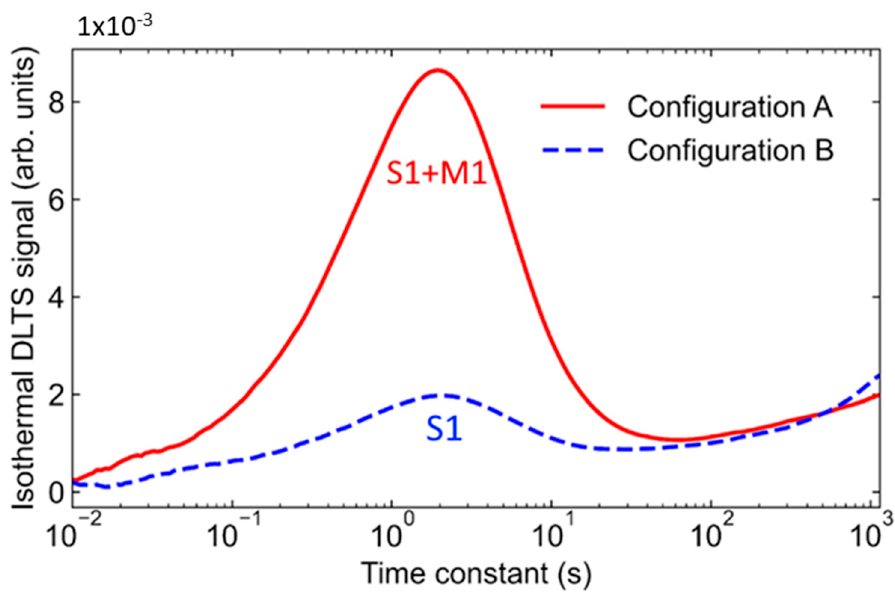
Figure 5. Isothermal DLTS spectra for neutron-irradiated 4H-SiC samples with M-center in configu- rations A (red, solid) and B (blue, dashed). Measurements are done at 180 K.